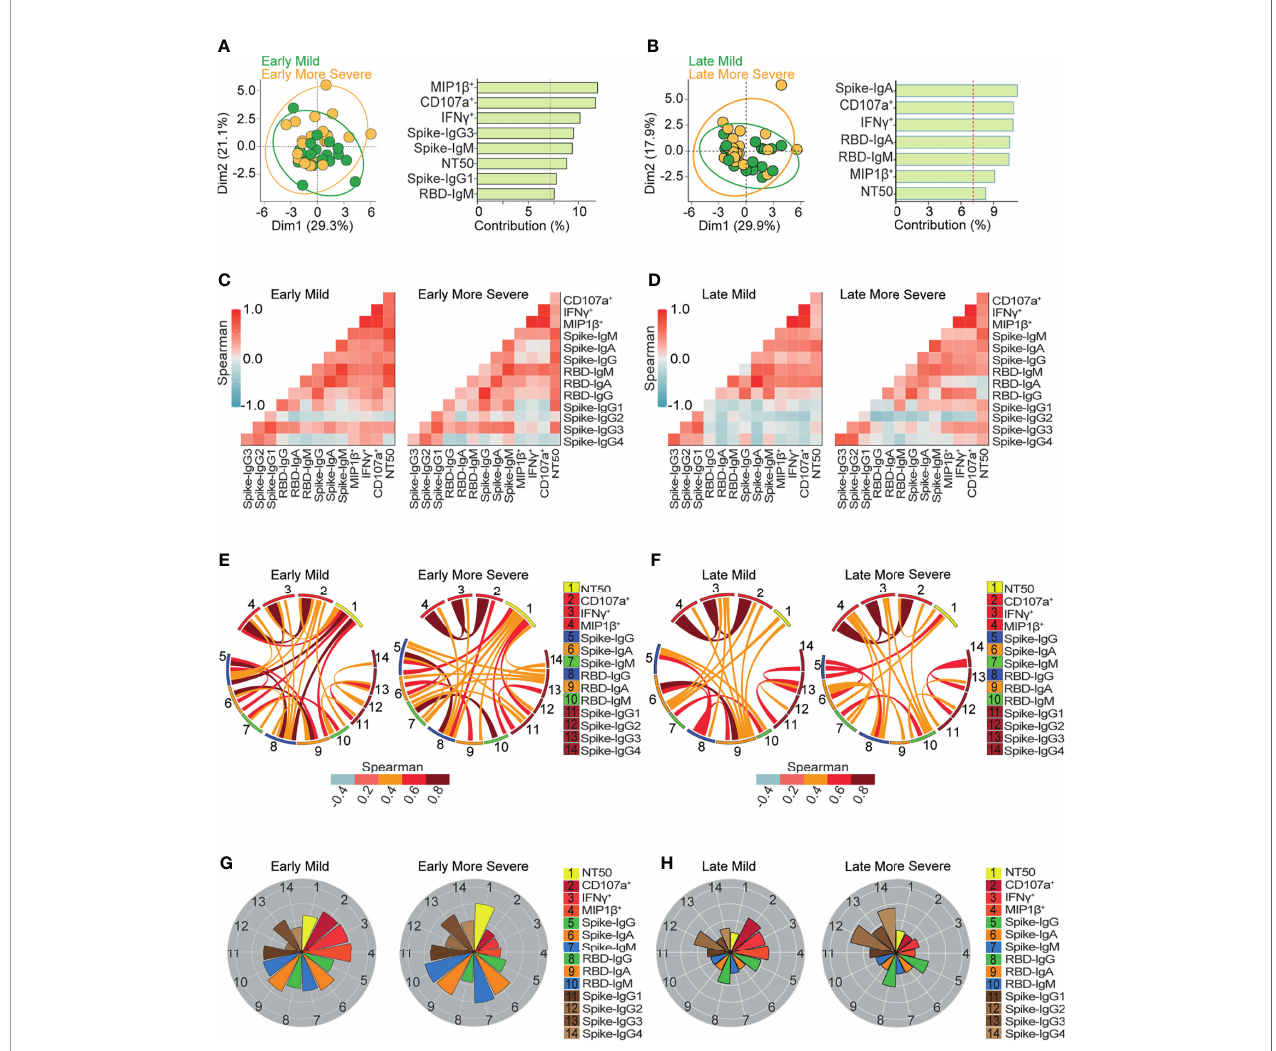
FIGURE 4 | Ab-dependent NK effector functions are prominently enriched in mild compared to more severe outpatients up to 6 months from the onset of symptoms. (A, B) Biplot showing the principal component analysis (PCA) depicting the early-mild (21 samples from 21 donors) and early-more severe (21 samples from 21 donors) sub-groups of COVID-19 outpatients (A) ; the late-mild (18 samples from 12 donors) and late-more severe (23 samples from 18 donors) sub-groups of COVID-19 outpatients (B) . The bar graph shows the contribution of variables for both dimensions (1 and 2) in the PCA analysis. (C, D) Correlation heatmap showing the Spearman ’ s r values between the complete set of variables analyzed for early-mild (21 samples from 21 donors) and early-more severe (21 samples from 21 donors) sub-groups of outpatients (C) ; or for late-mild (18 samples from 12 donors) and late-more severe (23 samples from 18 donors) sub-groups of outpatients (D) . The scale of blue-to-red color indicates a negative-to-positive correlation. (E, F) Circos plot showing signi fi cant Spearman correlations without adjustment between the pairs of variables displayed in (C) or (D) for early-mild and early-more severe sub-groups of outpatients (E) ; or for late-mild and late-more severe sub-groups of outpatients (F) . The color of the links represents the magnitude of Spearman ’ s r values. (G, H) Polar plots showing the differential composition of humoral immune responses at different sub-groups. Each bar represents the mean z-scores of variables for early-mild (21 samples from 21 donors) or more early- more severe outpatients (21 samples from 21 donors) (G) ; and for late-mild (18 samples from 12 donors) or more late-more severe outpatients (23 samples from 18 donors) (H)